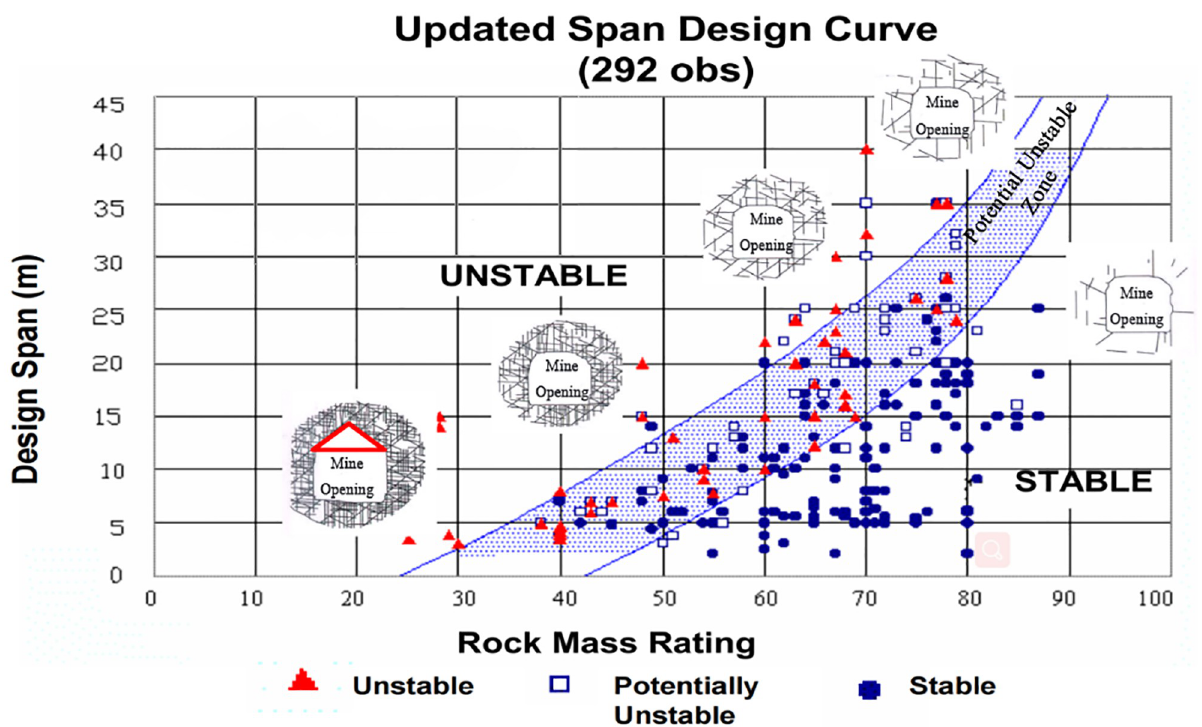
Fig 4. Limit span method (under the condition of no support or local support).